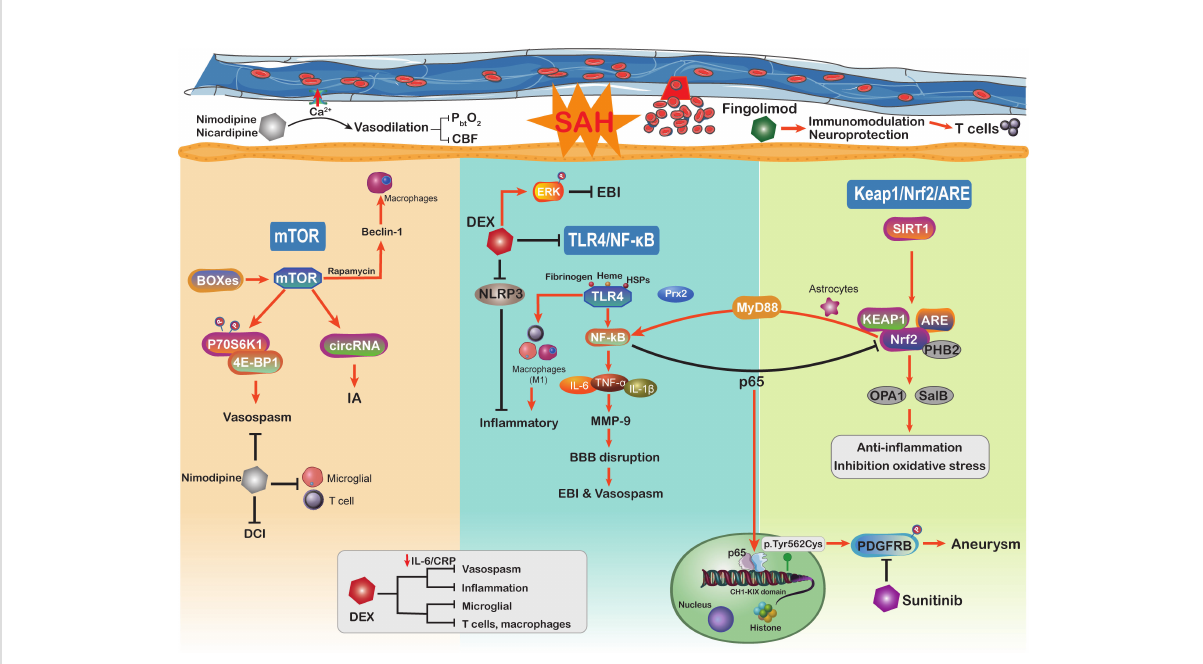
FIGURE 4 Schematic diagram of the mTOR, TLR4/NF-kB, Keap1/Nrf2/ARE signaling pathways and related therapy strategies in the pathophysiology of subarachnoid hemorrhage. CBF, cerebral blood fl ow; DEX, dexmedetomidine; CRP, C-reactive